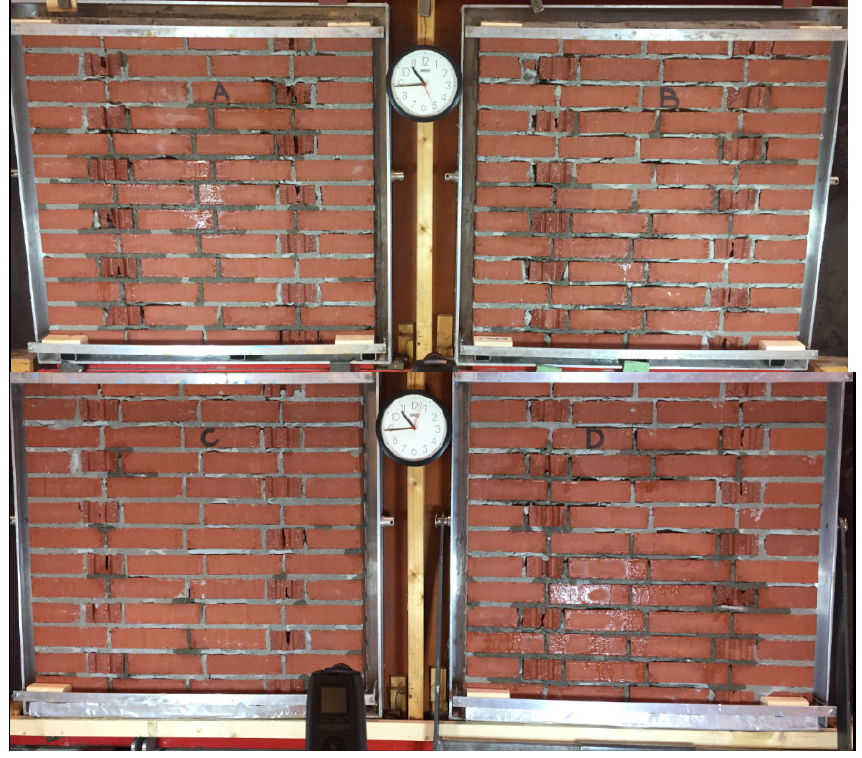
Figure 4. Panels A, B, C, and D after 45 min of simulated driving rain.